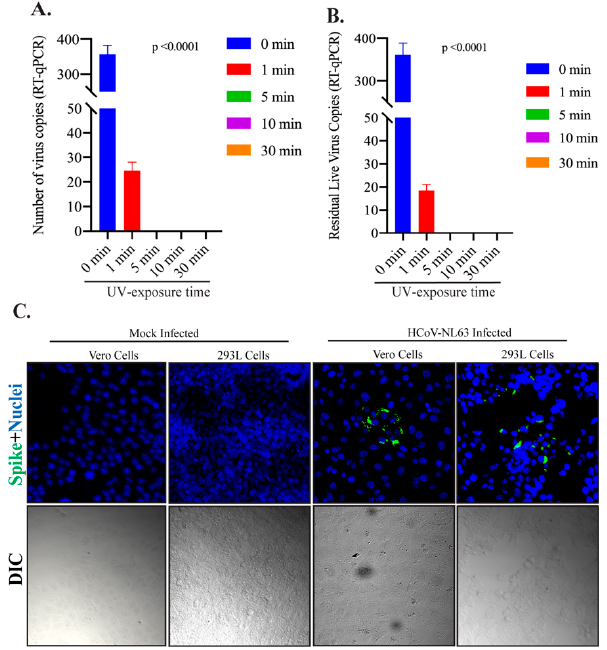
Figure 2. The effect of UV exposure on HCoV-NL63 viral genomic RNA stability. ( A ) HCoV-NL63 virus (100 µ L) was placed on coverslips and exposed to UV light for indicated time (0, 1, 5, 10, and 30 min). Total RNA was extracted and used for the detection of viral copies by RT-qPCR. ( B ) HCoV-NL63 virus (100 µ L) was exposed to UV light for indicated time (0, 1, 5, 10, and 30 min), collected, and used for the infection of HEK293L cells. Total RNA was extracted at 48 h post-infection for the detection of intracellular viral genomic copies in a RT-qPCR assay. Viral copies were calculated based on a standard curve generated using the known amounts of virus obtained from BEI Resources (material and method section). ( C ) 100 µ L of HCoV-NL63 was added onto a monolayer of Vero E6 or HEK293L cells and incubated for 48 h before fixing them for immunofluorescence assay. HCoV-NL63 infected as well as respective mock infected cells were stained with anti-CoV antibody for spike glycoprotein. Immune localization of spike proteins showed specific signals (green fluorescent dots) in HCoV-NL63 infected but not in mock infected cells. Nuclei were stained with TO PRO-3 (blue signals). Differential Interference Contarst (DIC) images were captured to see the cellular morphology.